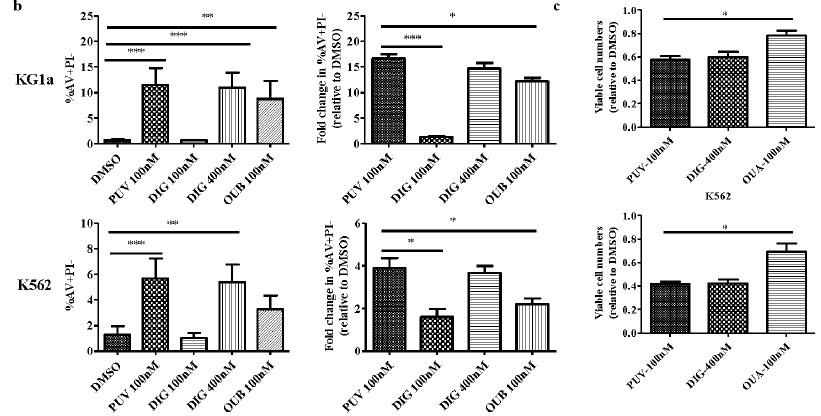
Figure 2. Peruvoside is more effective in inducing apoptosis in human leukemia cells. ( a ) Flow cytometry analysis of Annexin V (AV) and Propidium Iodide (PI) expression in KG1a and K562 treated with various CGs at different concentrations for 24 h; ( b ) Graphs show the percentage of early apoptotic cells (AV + PI − ) measured in ( a ) as well as the fold changes in the percentage of AV + PI − (treatment/DMSO); ( c ) Graphs show the fold changes in viable cell numbers (treatment/DMSO). PUV, Peruvoside; DIG, Digitoxin; OUB, Ouabain. n ě 3, * p < 0.05; ** p < 0.01, *** p < 0.0001.